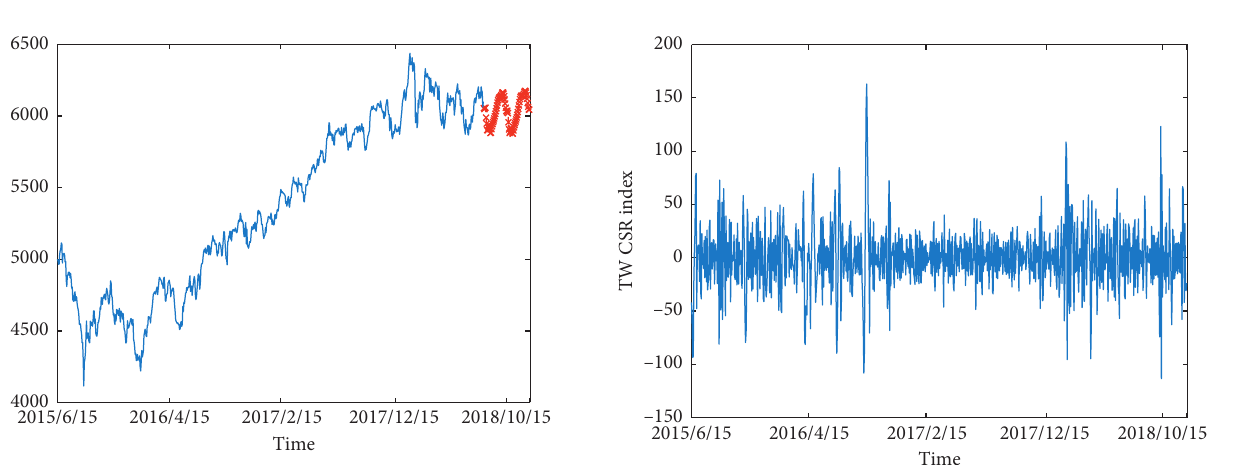
Figure 3: Taiwan CSR index as predicted by the LSTM model.